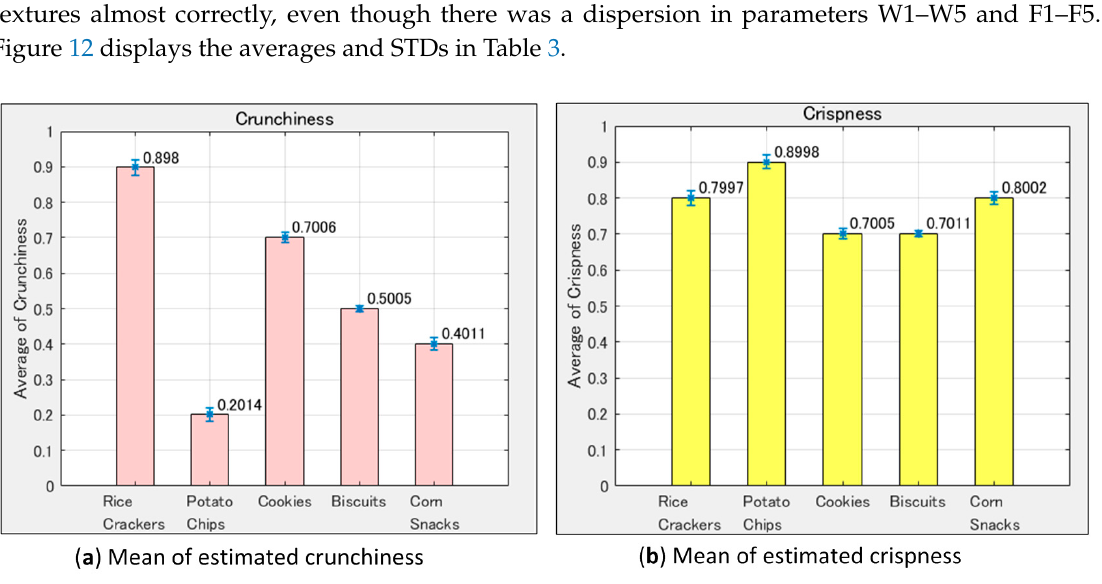
Figure 12. Texture evaluation results of the samples: ( a ) The mean of estimated crunchiness degree and ( b ) crispness degree.